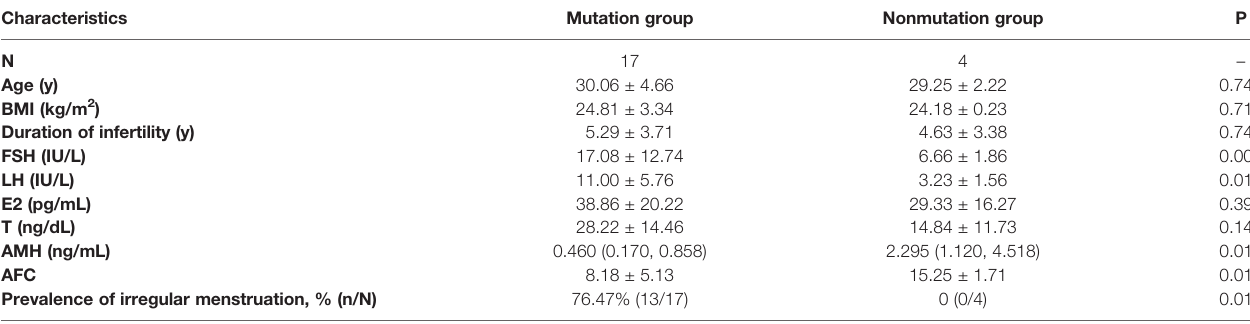
TABLE 2 | The ovarian reserve in BPES patients with and without FOXL2